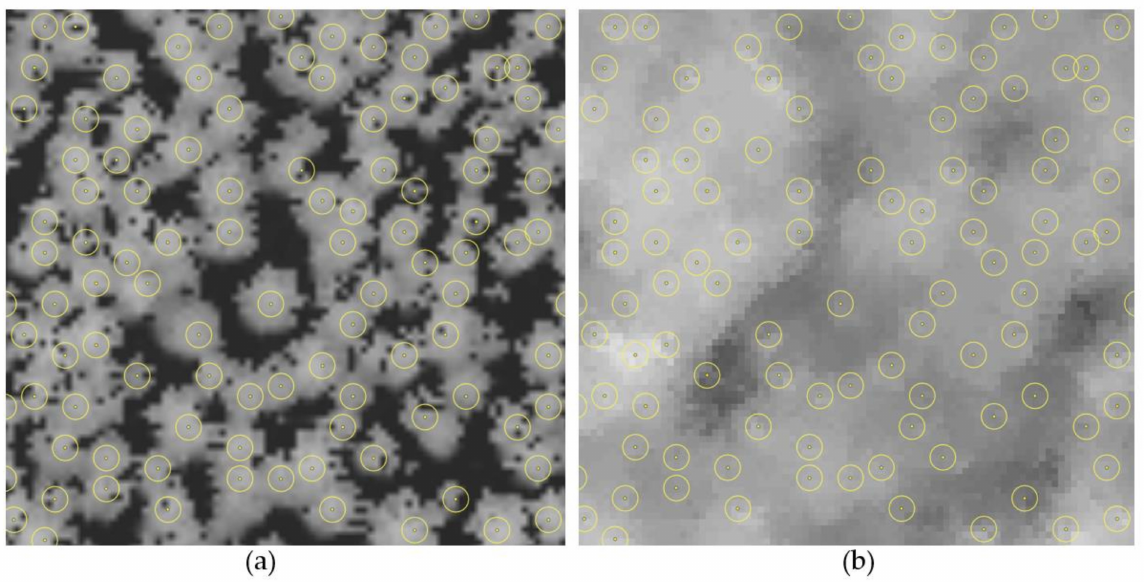
Figure 4. DSM fragments 40 × 40 m of the study area. Spruce canopy peaks (yellow dots) extracted from LiDAR-based DSM ( a ) by local maxima approach with 1 m radius (yellow circles) for collecting grid statistics (heights) from image-based DSM ( b ). The GE1-PAN DSM ( b ) represents the non-transparent outer “canopy envelope” or “canopy blanket” cover of dominant trees compared to LiDAR-based DSM ( a ).